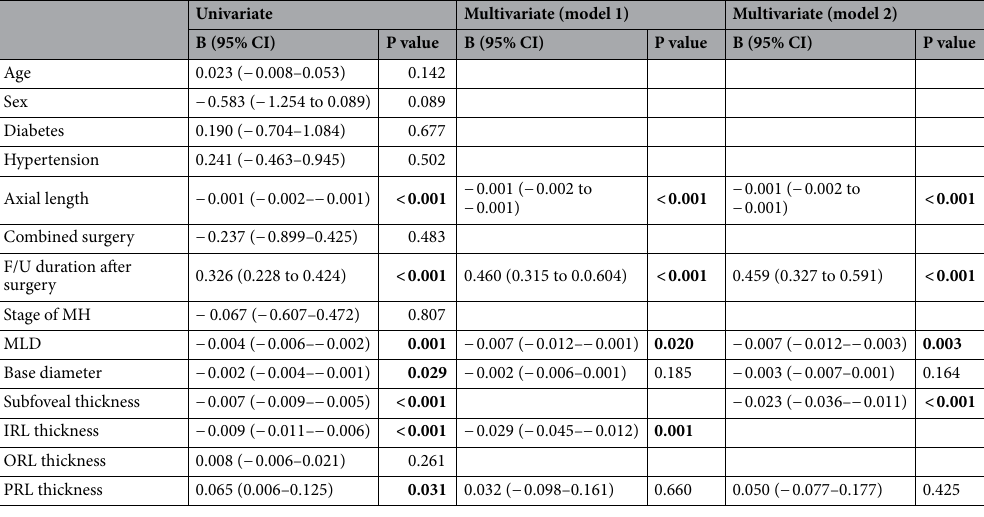
Table 5. Univariate and multivariate generalized estimating equation to identify factors associated with the recovery of ellipsoid zone. Values in boldface are statistically significant (P < 0.050). F/U follow-up, MH macular hole, MLD minimum linear diameter, IRL inner retinal layer, ORL outer retinal layer, PRL photoreceptor